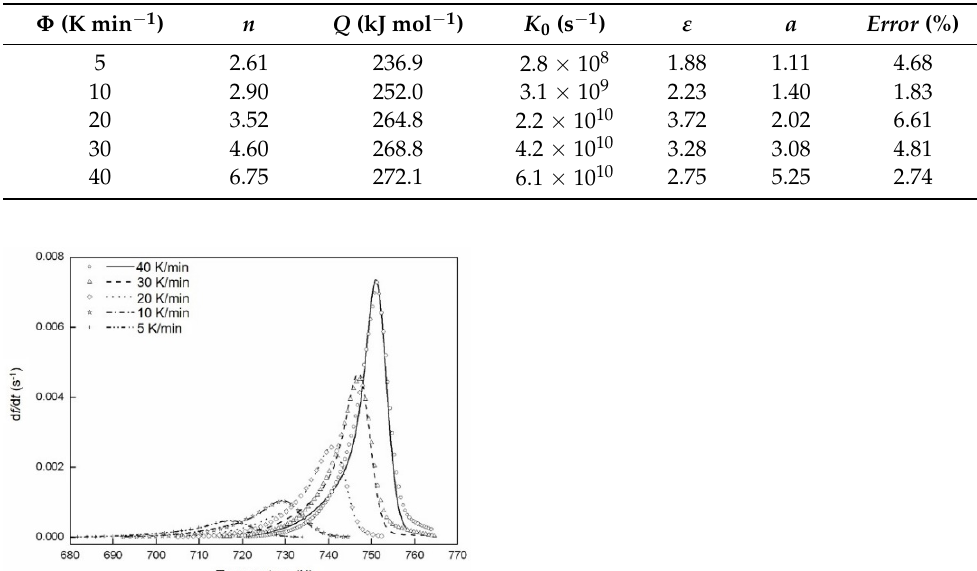
Table 1. Kinetic parameters n , Q , K 0 , nucleation index a and impingement factor ε , as determined by fitting the measured DSC curves using the current model for the isochronally crystallized amorphous Fe 85 B 15 alloy (see Section 4.3), with the initial assumed values n = 4, K 0 = 1 × 10 9 s − 1 , Q = 300 kJ mol − 1 during fitting.